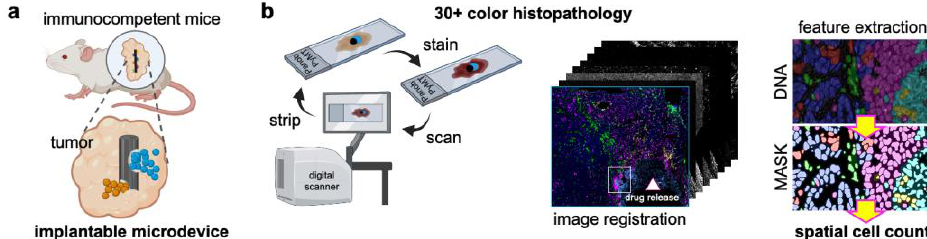
Figure 1. Multiplex implantable microdevice assay (MIMA) components. ( a ) A schematic presen- tation of the implantable microdevice inserted into the tumor of an immunocompetent mouse and a magnified view of two drugs released into spatially separate regions of the same tumor. ( b ) Multiplex immunohistochemistry (mIHC) on a single FFPE slide, including the drug-affected region of the tumor. mIHC uses iterative (i) staining by the deposition of chromogen, (ii) a brightfield digital scanner to image the target signal, and (iii) stripping the target signal with organic solvents (left). The images were co-registered, including the nuclear staining (DNA), which defines the mask for single-cell segmentation and the spatial cell count (right). In this way, 30+ markers could be evaluated in each individual cell.